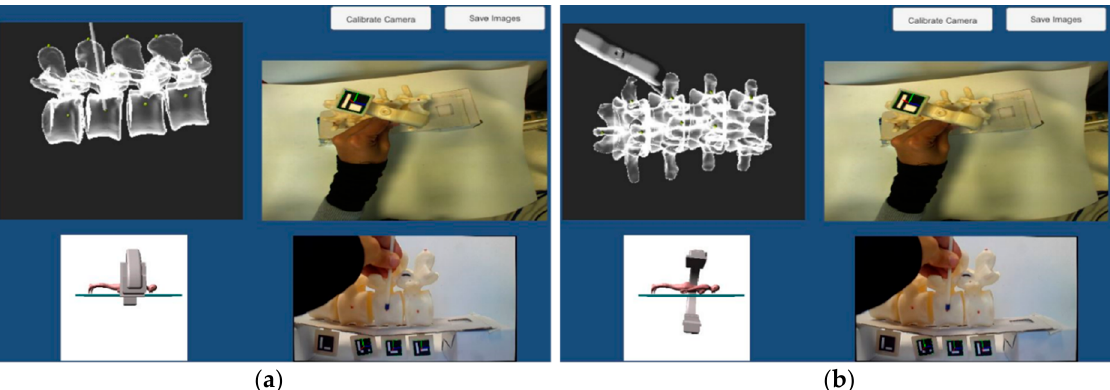
Figure 10. Two screenshots of the User Interface during the targeting of a landmark with a trocar mockup. ( a, left ) The pose of the Virtual C-Arm is adjusted to simulate a lateral fluoroscopic image. ( b, right ) The pose of the Virtual C-Arm is adjusted to simulate an anterior–posterior fluoroscopic image.